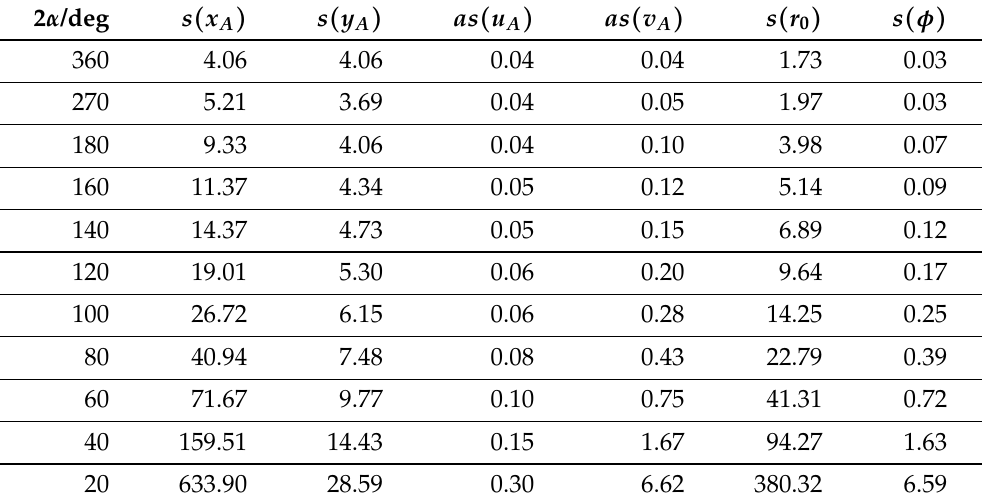
Table 7. Arc segment of a cone. Square roots s ( a ) of the diagonal elements of V a αφ as a function of α . For points x 1: m approximately uniformly distributed over a segment of a cone with cone angle φ = 45 degrees, − α ≤ θ i ≤ α ≤ π and − a ≤ z i ≤ a , and point-cloud variance matrix V X = σ 2 √ m uncertainties u ( a ) = σ R s ( a ) /